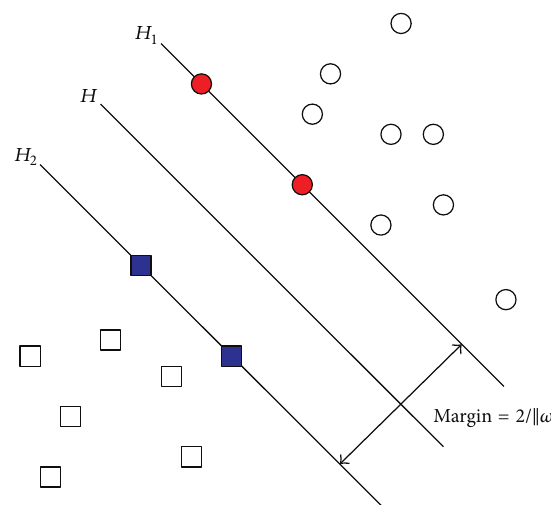
Figure 1: Schematic of the optimal